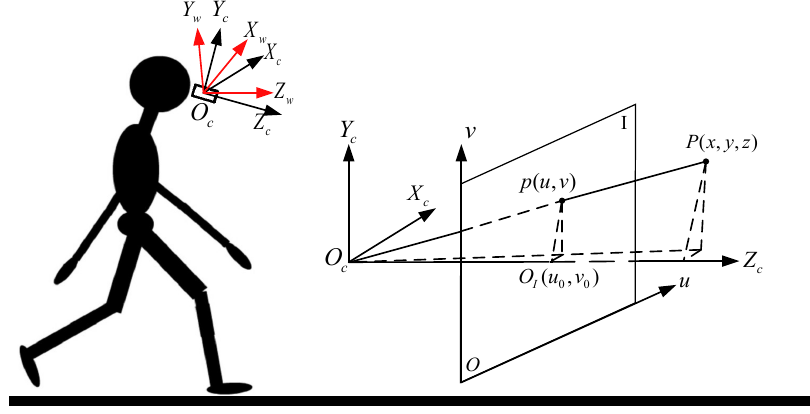
Figure 4. Coordinate system